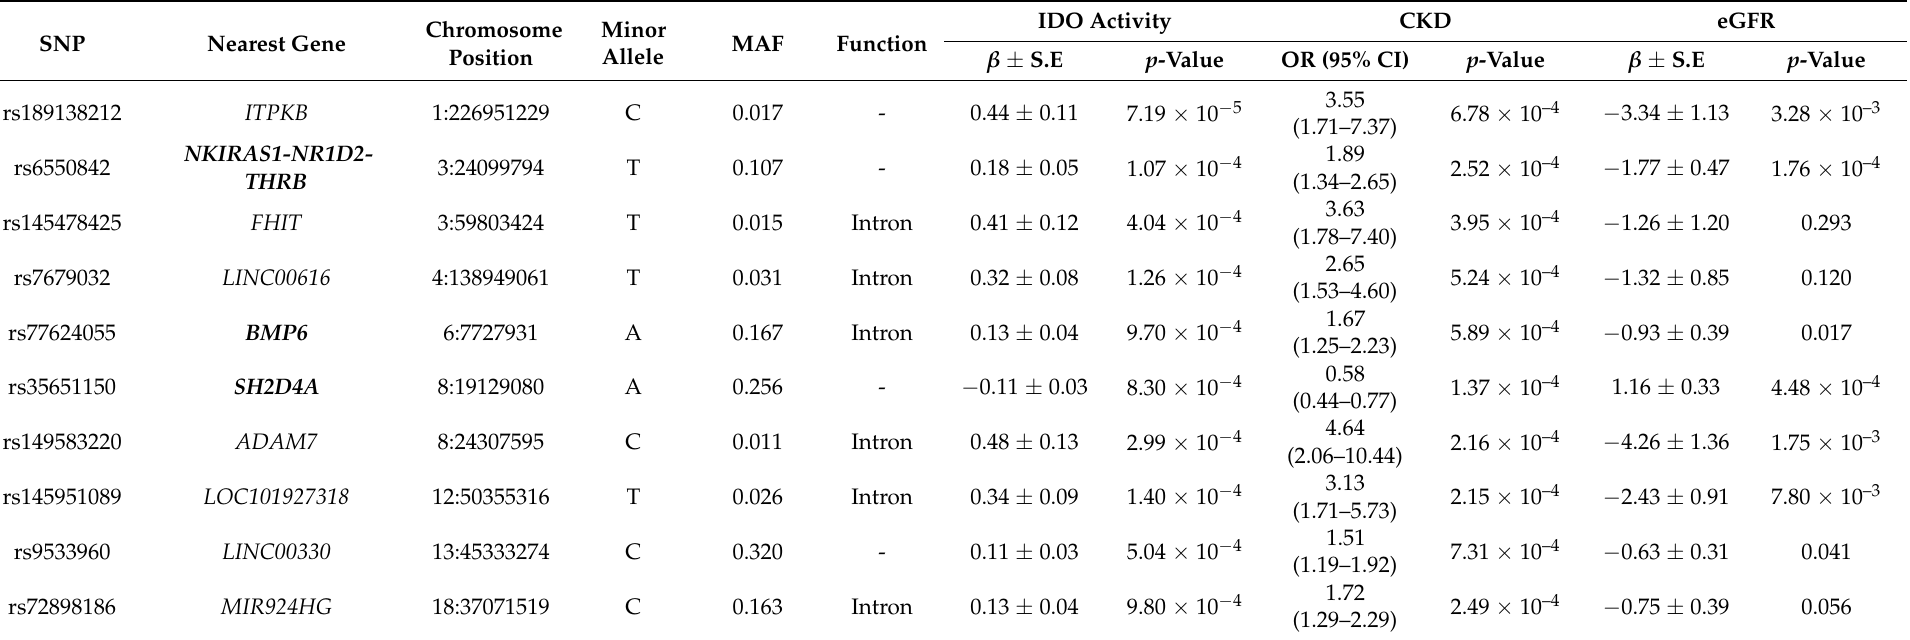
Table 2. Loci associated with both indoleamine 2,3-dioxygenase activity and chronic kidney disease in